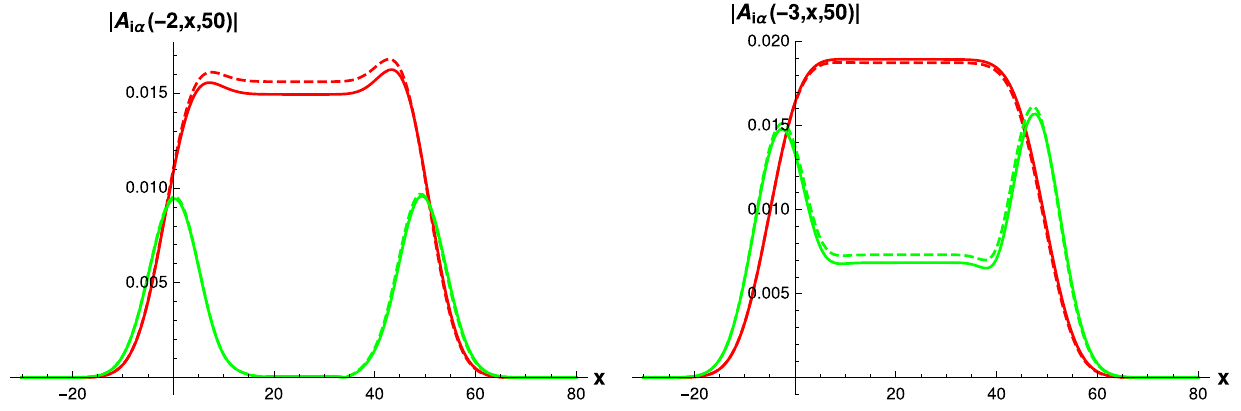
Fig. 7 As in Fig. 6 but for a smaller mass splitting and worse momentum resolution. The phases are not shown